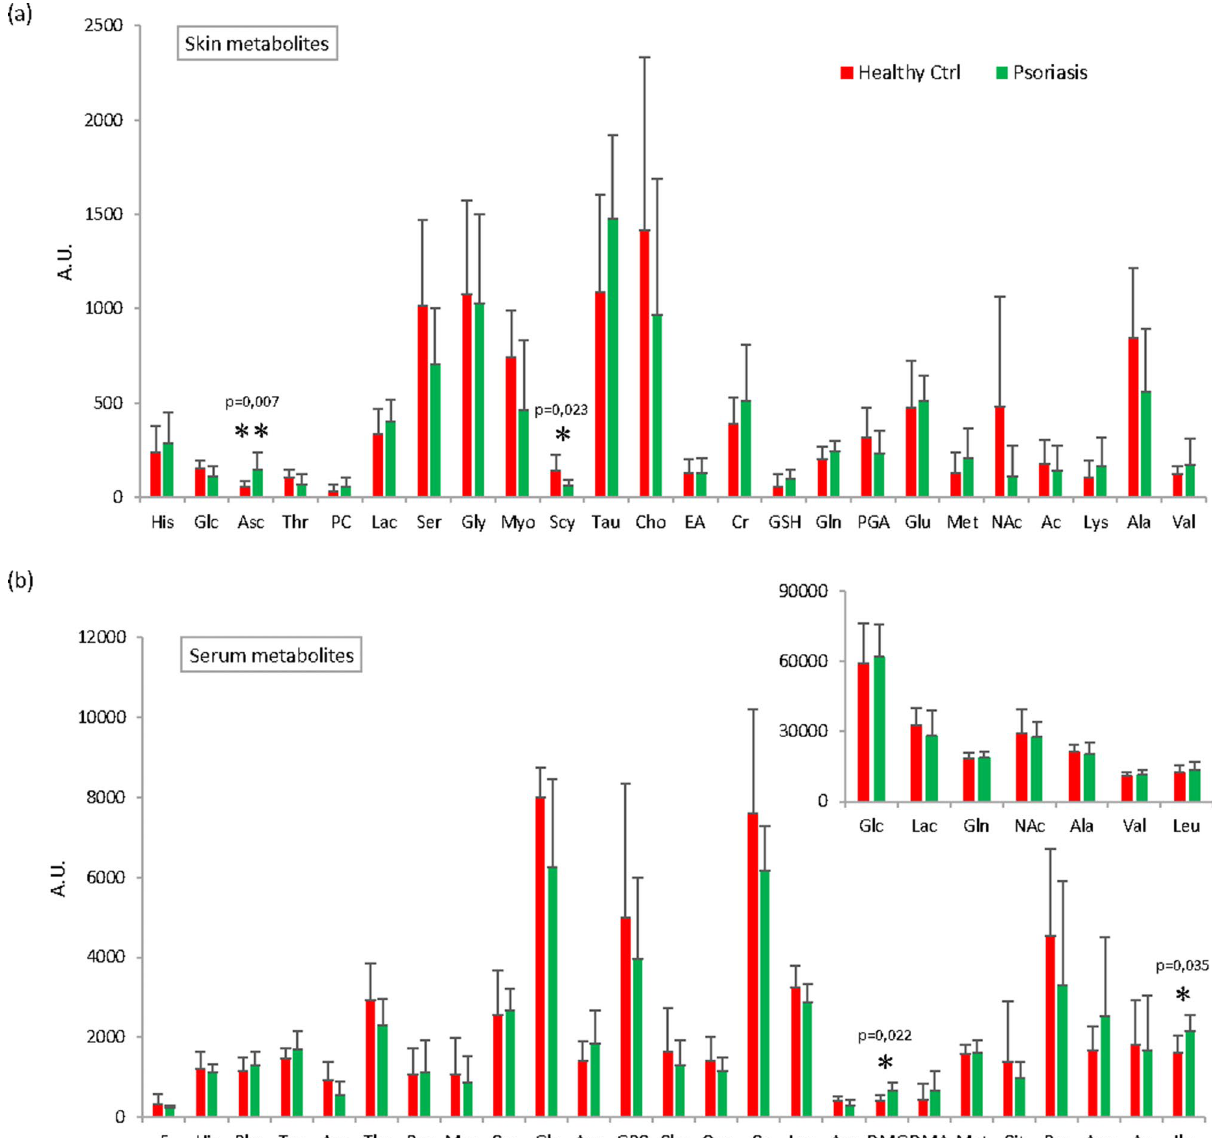
Figure 1. Relative quantification of metabolites after deconvolution of NMR signals. The bar plots show the relative amounts (mean ± standard errors) of metabolites identified in ( a ) skin and ( b ) in serum samples. ( b ) Some metabolites are reported in two bar charts with different y-axis expansions. Statistically significant (p < 0.05) changes in metabolite levels of Asc and Scy ( a ), DMG and Ile ( b ) detected by t-test are indicated by asterisks. Figure produced by Topspin (Bruker) Version 4.0.7 (https:// www. bruker. com/ conte nt/ bruker/ int/ en/ produ cts- and- solut ions/ magne tic- reson ance/ nmr- softw are. html). No permission